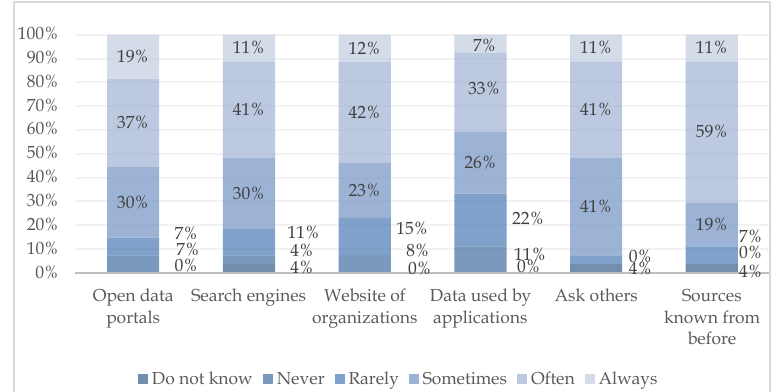
Figure 2 Questionnaire results - How data users look for